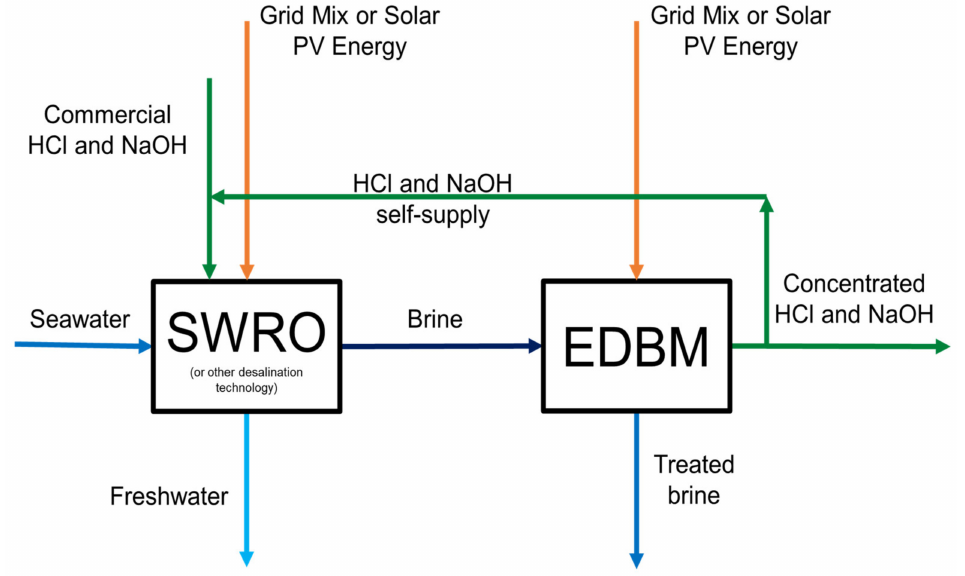
Figure 3. Alternative A1 flow